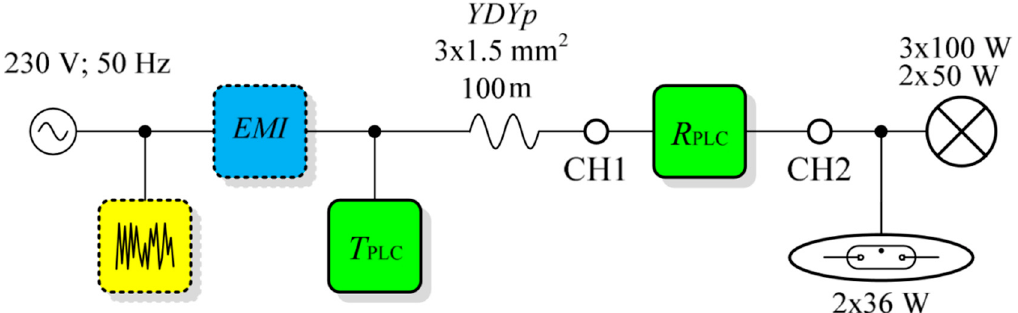
Figure 19. Connection schematic of the model with an EMI filter while LED lighting systems with power supplies and a fluorescent lamp with a power supply system working as the receiver, the receivers were connected without the proposed filtering system (TEST 4).